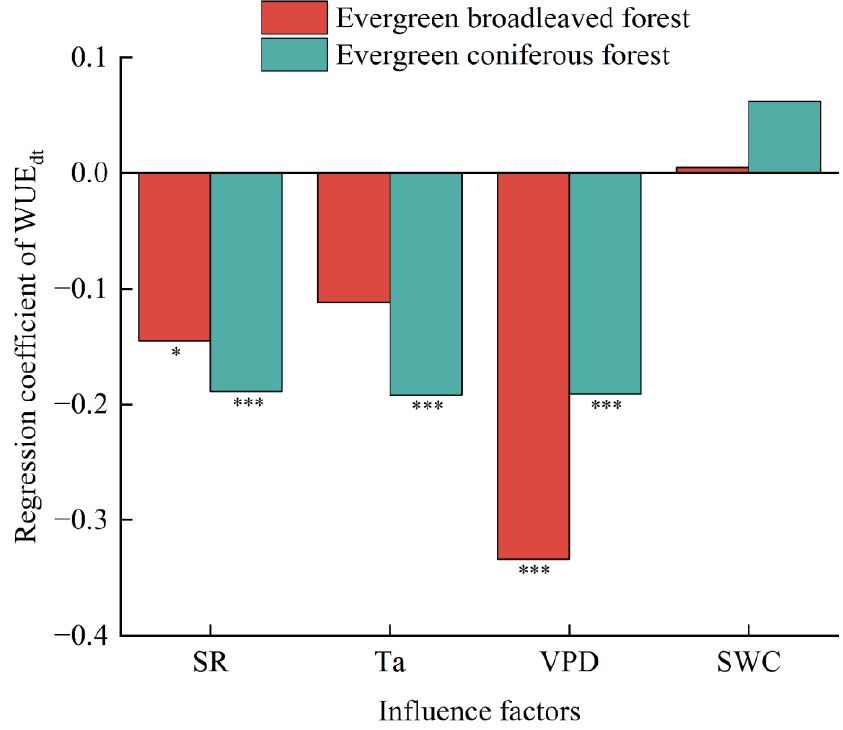
Figure 5. Regression coefficients of meteorological conditions (SR, T a , VPD, and SWC) with WUE dt in the broadleaved forest at Dinghushan and in the coniferous forest at Qianyanzhou. “*” indicates that r is at the 90% significance level ( p < 0.10), and “***” at the 99% level ( p < 0.01).